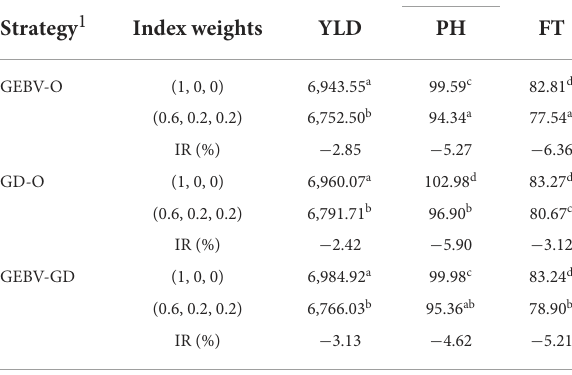
TABLE 1 GEBV averages of the best F 10 inbred lines for the tropical rice